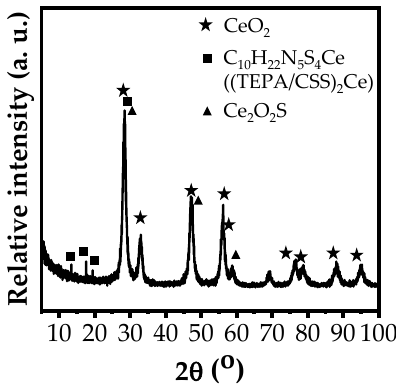
Figure 3. XRD spectrum of the synthesized (TEPA/CSS) 2 Ce complex.